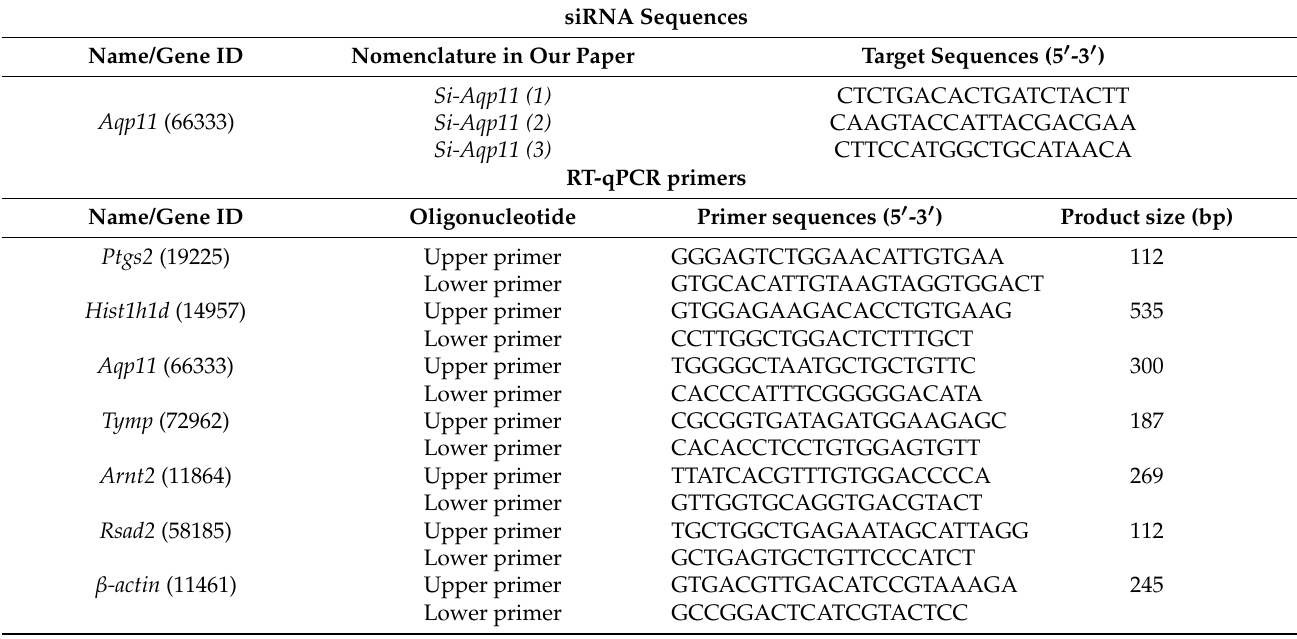
Table 2. The primer sequences used in the present study. siRNA